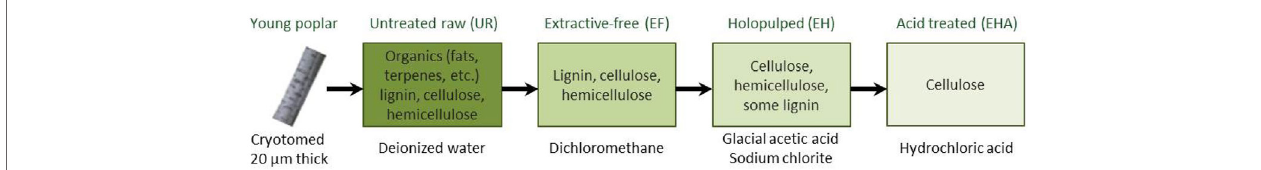
FiGURe 1 | Chemical steps for delignification process starting from a cryotomed young poplar. AFM studies are carried out at each step of the process, i.e., on untreated raw (UR), extractive-free (EF), holopulped (EH), and acid-treated (EHA) samples (adapted from Farahi et al.